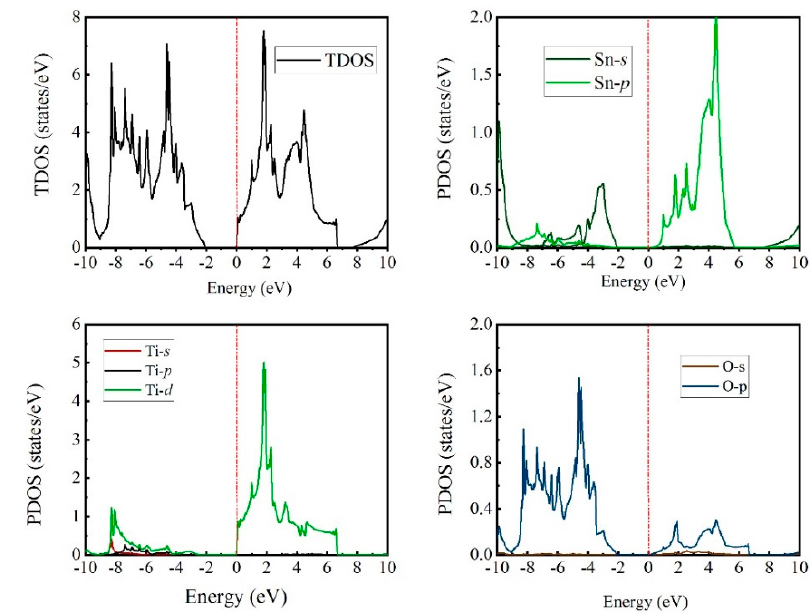
Figure 3. Total and partial density of states as obtained with HSE06.